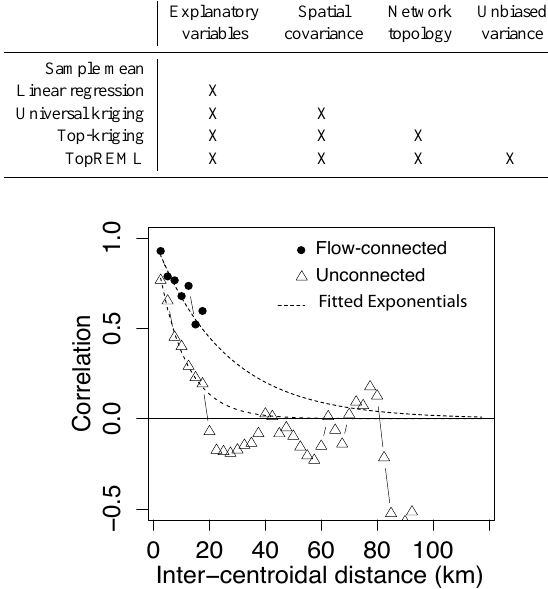
Figure 2. Empirical correlograms of the mean specific summer flow recorded at the 57 gauges of the Austrian data set. Distance has a different effect on the correlation between flow-connected (black circles) and flow-unconnected (white triangles) gauges. Both cor- relograms are well fitted by an exponential function but the spatial correlation range doubles when gauges are flow connected. Both empirical correlograms are constructed using 5km